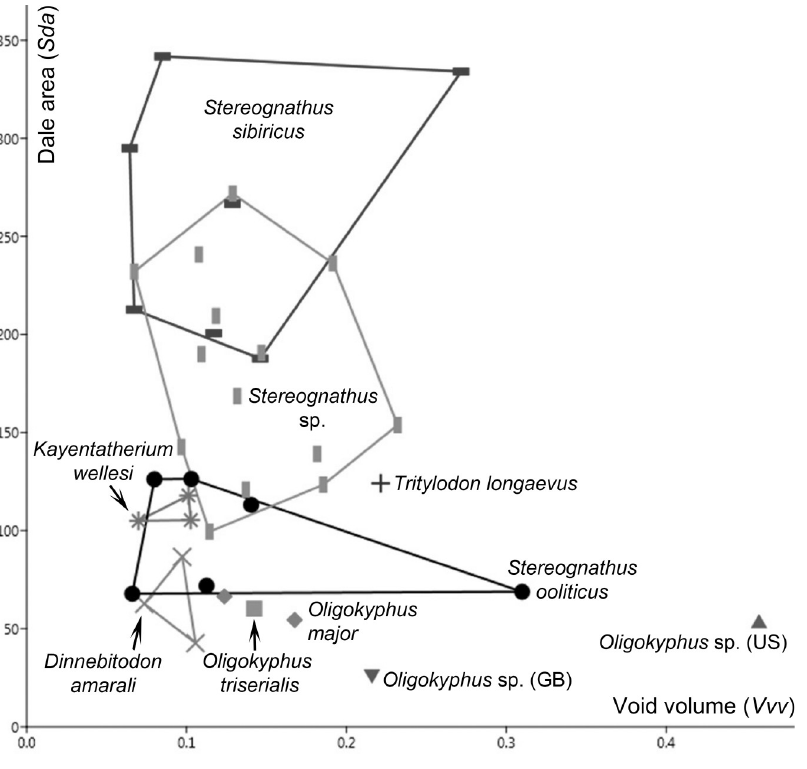
Fig 6. Bivariate plot of surface texture parameters pit void volume ( Vvv in μ m 3 / μ m 2 ) versus mean dale area ( Sda in μ m 2 ). Convex hulls embrace the area taken by each taxon (for taxa > 2); symbols represent individual